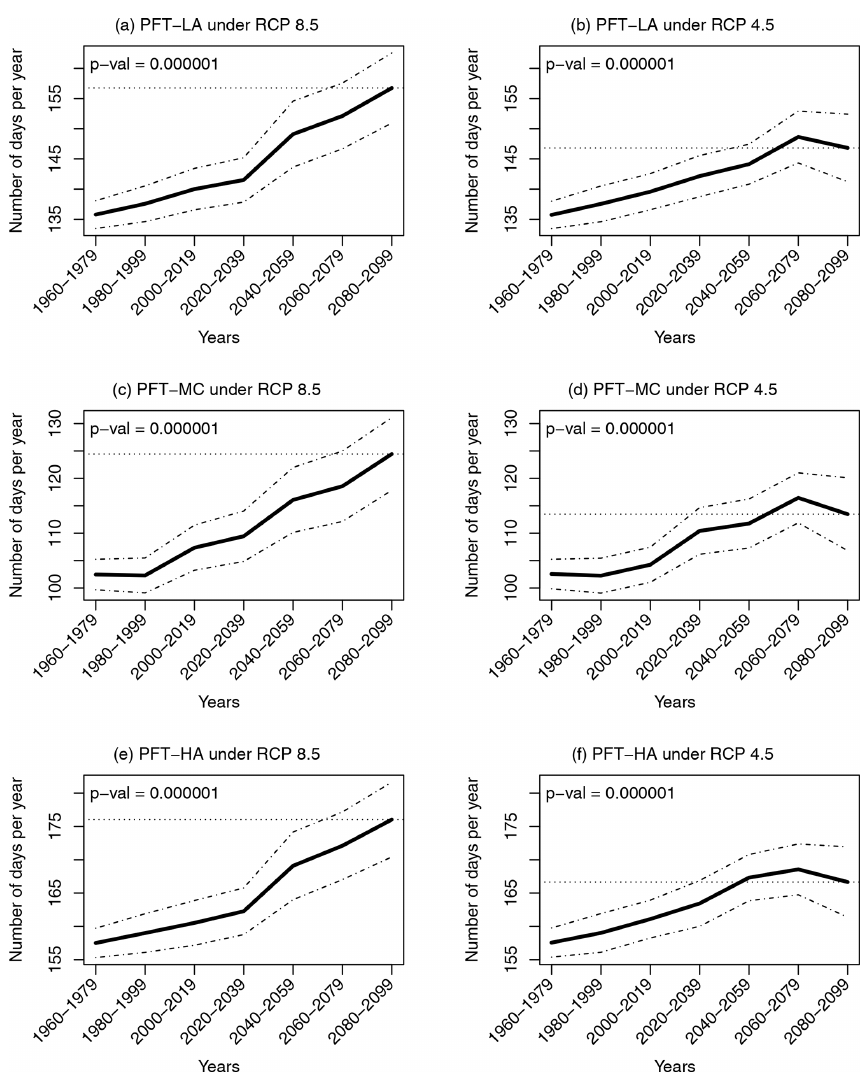
Figure 4. Temporal changes in average number of days per year of live fuel moisture content below 79% (black solid line) and 95% confidence interval (black dash-dot line) from 1960 to 2099 for three PFTs (see Fig. 1 for an explanation of the PFTs) under climate scenario RCP4.5 and 8.5 with 20 Earth system models considering all climatic variables changes. The p values were calculated using bootstrap sampling to test whether the number of days across different models during the future period (2080–2099) was significantly higher than that during the historical period (1960–1999). The gray horizontal dotted line represents the ensemble mean for